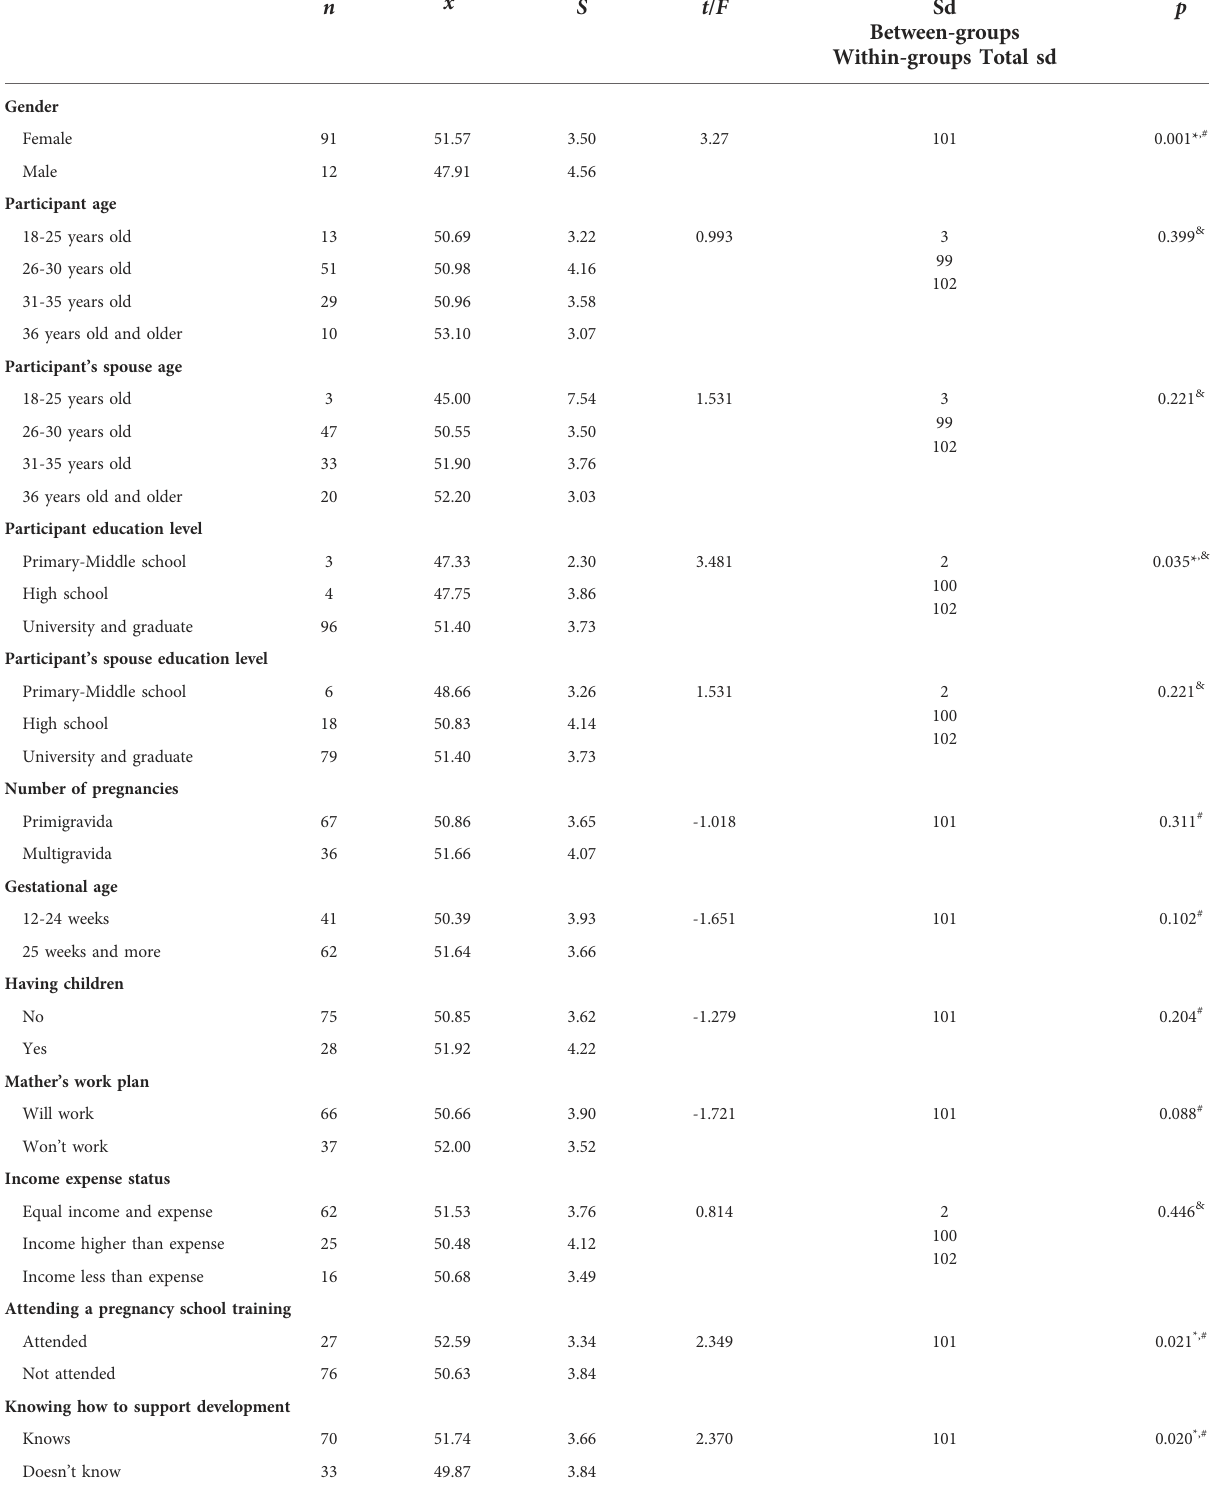
Total Knowledge Level of NC Sd